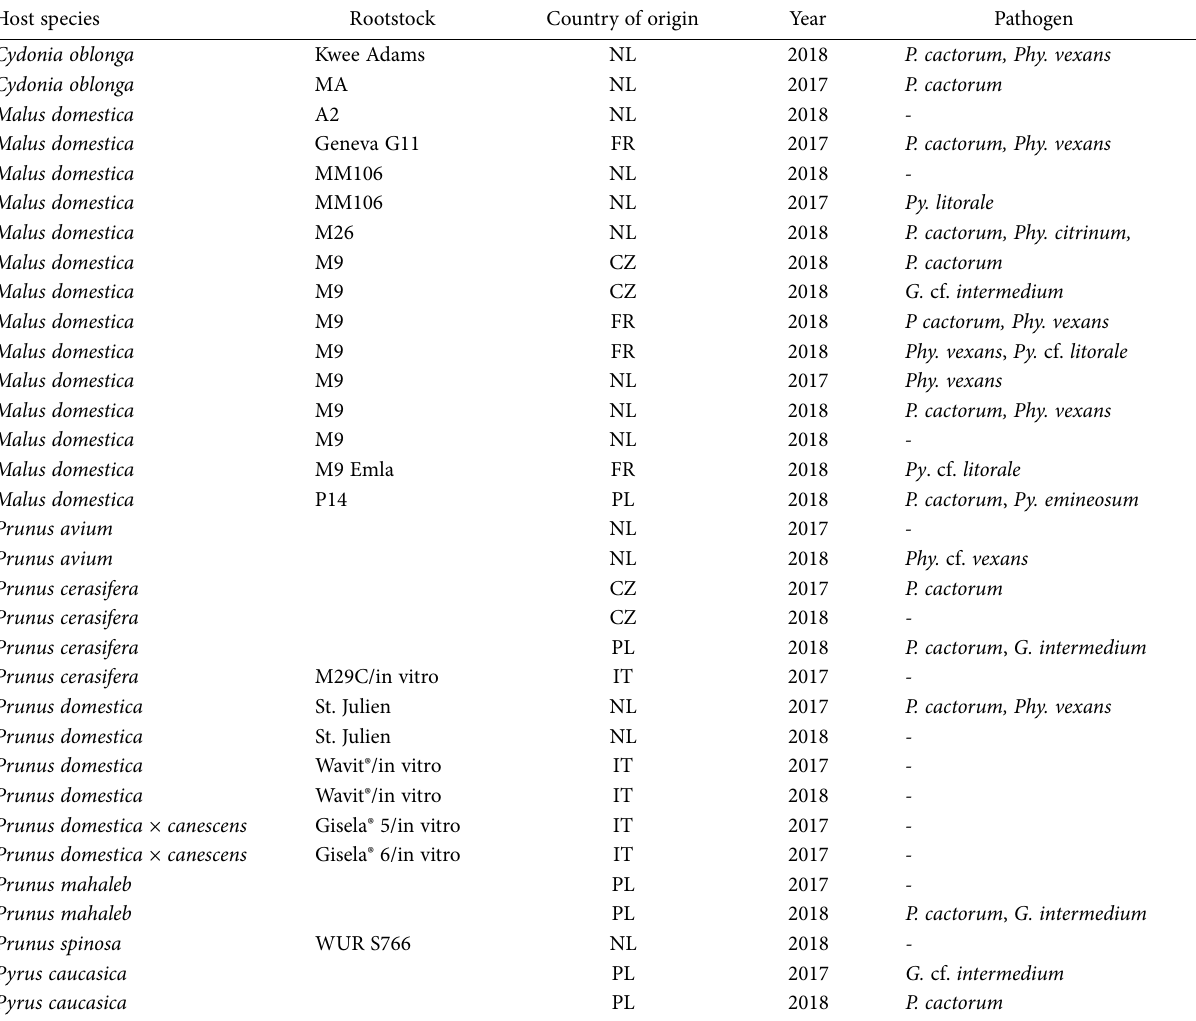
Table 2. Overview of Phytophthora and Pythium s. l. isolations from commercial nursery